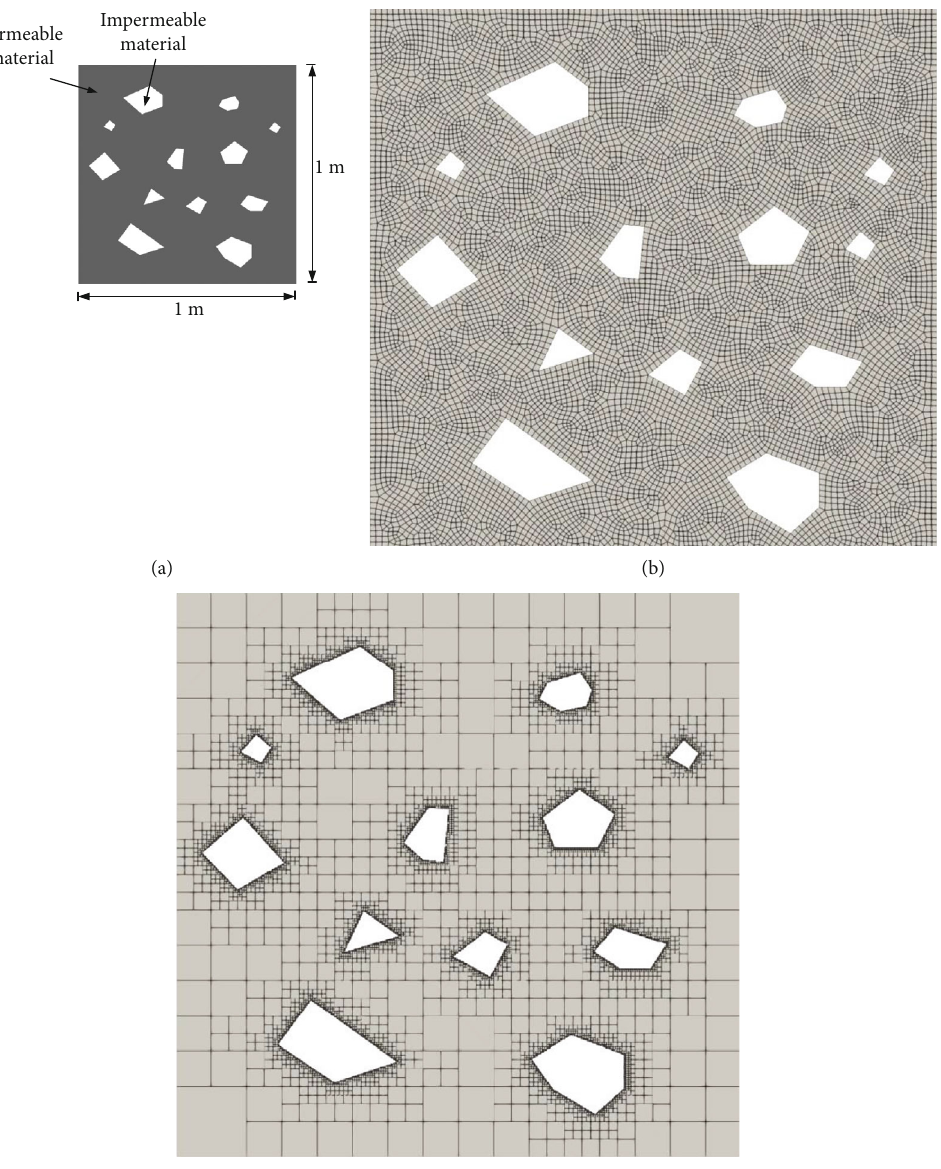
Figure 7: Permeable material ’ s geometric model and quadtree mesh: (a) geometric model; (b) Abaqus CPE4P mesh; (c) PSBFEM quadtree